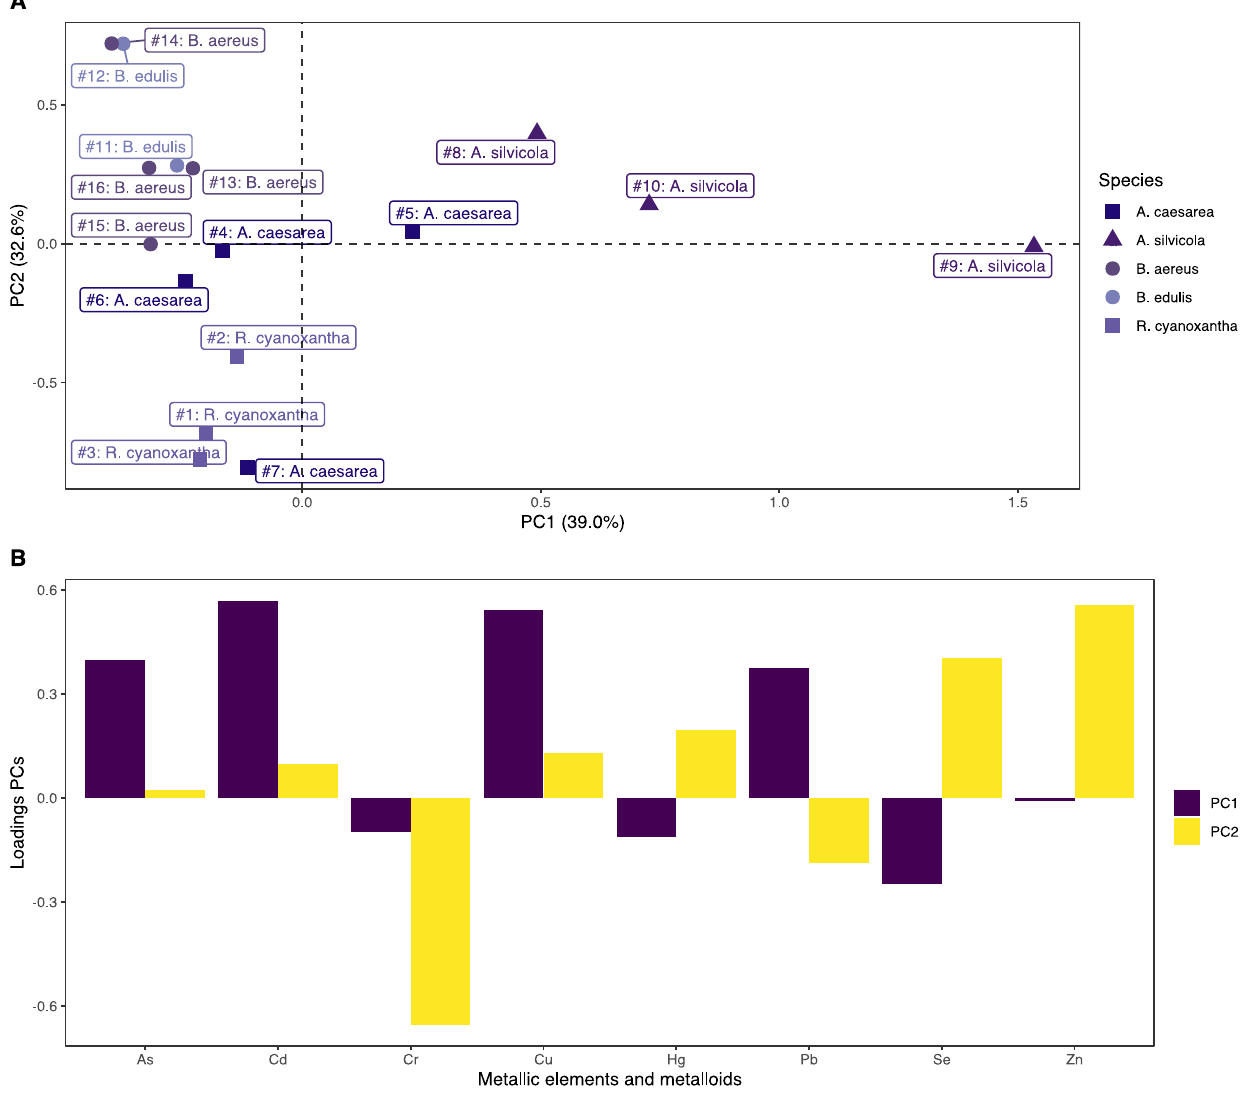
Figure 2. ( A ) Score obtained for PC1 and PC2 for all the samples (n = 16); ( B ) Loadings obtained in PC1 and PC2.